Question: How would you classify this visualization?
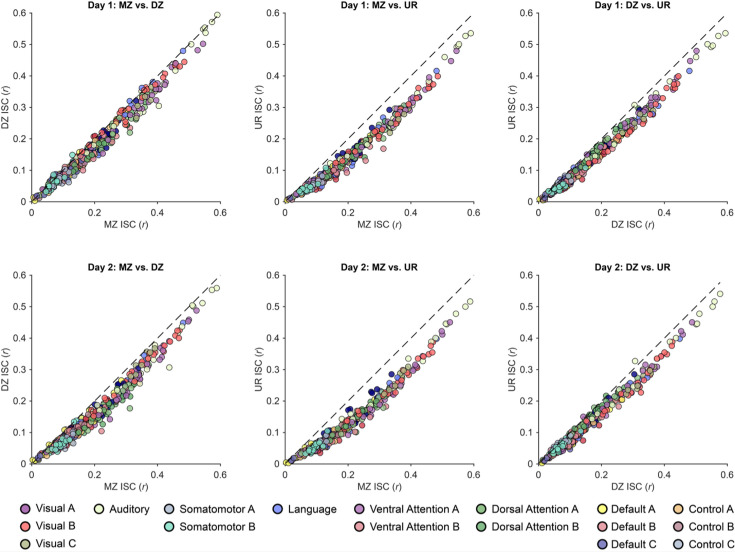
Answer: line